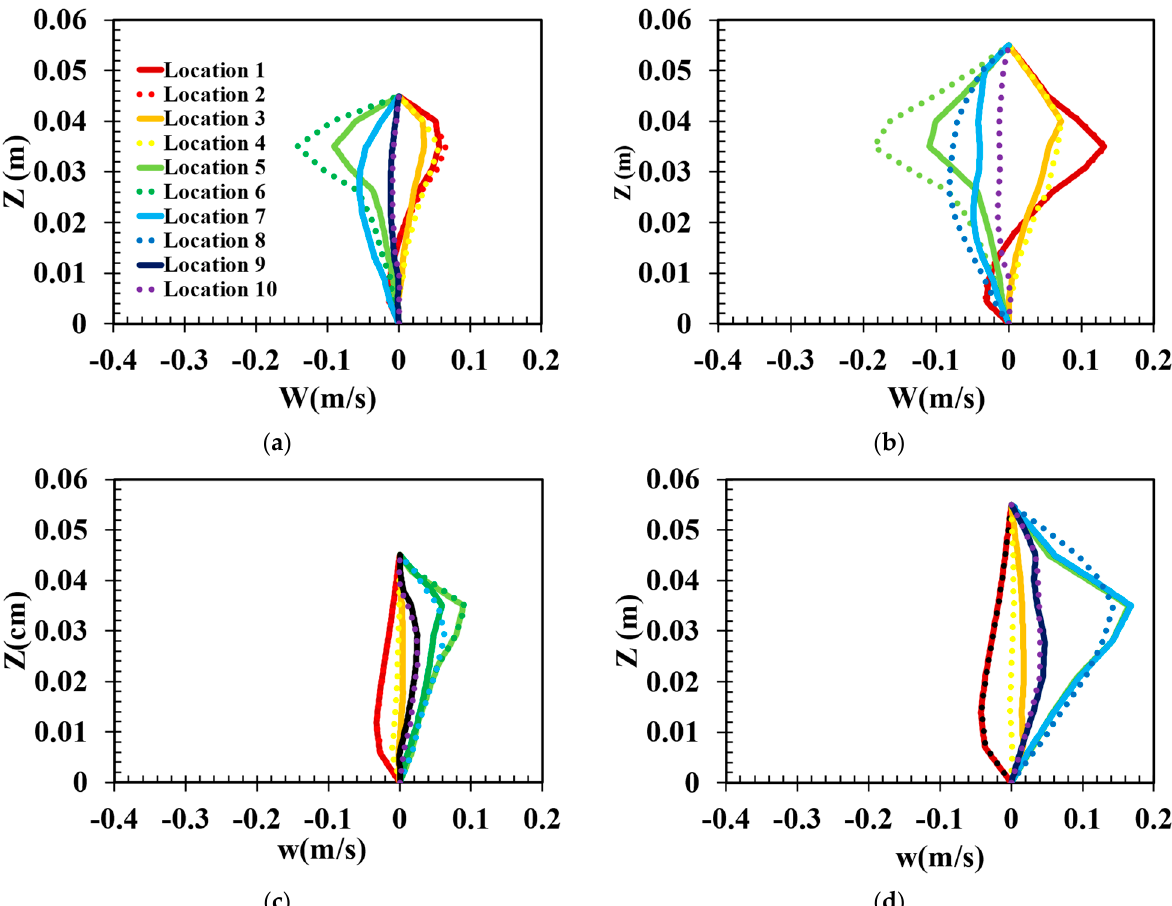
Figure 7. ( a – d ) The simulated results of vertical velocity profiles ( w ) at specified locations: ( a ) case 1; ( b ) case 2; ( c ) case 3; ( d ) case 4.